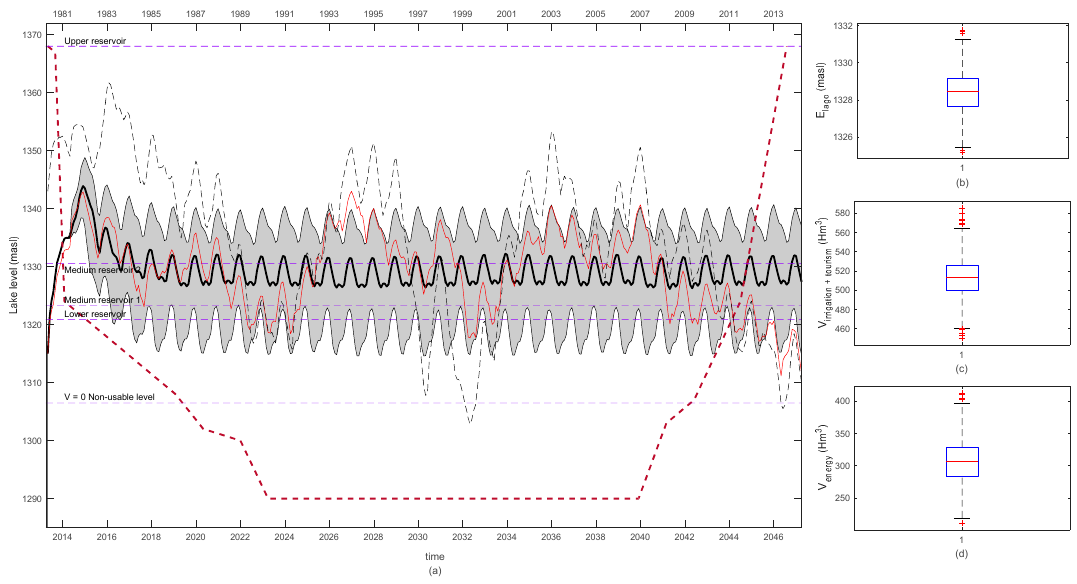
Figure 6. ( a ) Uncertainty bands (gray area) and median (black line) of simulated scenarios under a climate variability and change scenario and the proposed allocation rule. For reference, a conceptual diagram of the lake is shown in a bold dashed brown line and reference reservoir levels are shown in purple dashed lines. The red line shows simulation results for the level simulations from April 2014 to March 2047 (bottom axis), while the dashed black line shows the recorded levels from April 1980 to March 2014 (top axis). Box plots show lake elevations (E Lake ) ( b ) water allocation for irrigation and tourism ( c ) and water allocation for energy ( d ) according to the new rule.